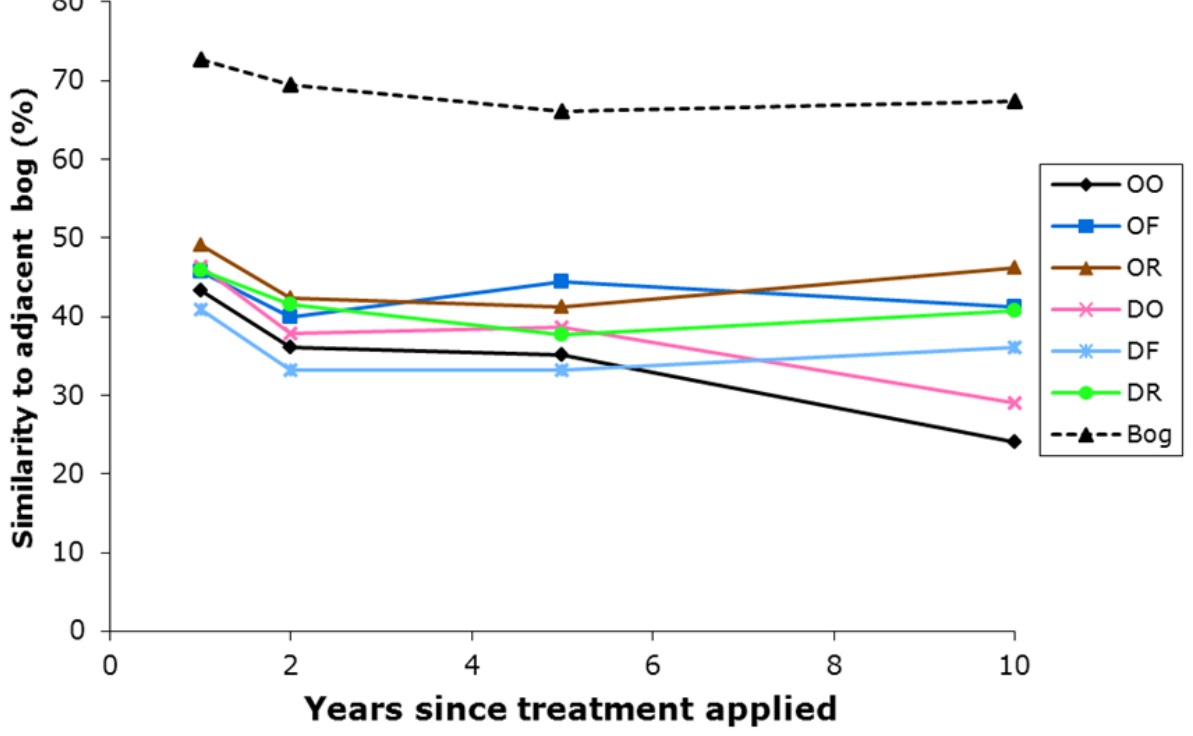
Figure 8. Vegetation recovery over time following restoration. The Sorensen Index was used as a measure of how similar the species composition of vegetation in the various treatments was to that of the adjoining undisturbed bog. Similarity among quadrats on undisturbed bog is included to show the inherent